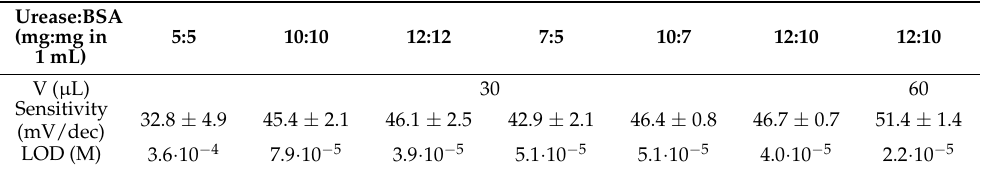
Table 1. Comparison of basic metrological parameters for urease-modified sensors, (measurements repeated 3 times for each group of six sensors, n = 3).